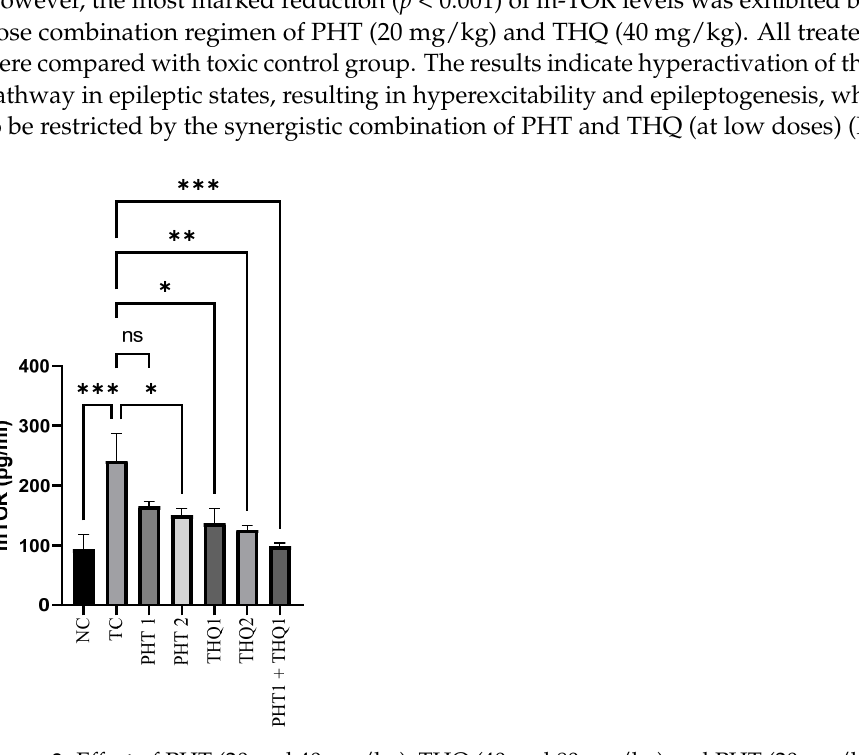
Figure 3. Effect of PHT (20 and 40 mg/kg), THQ (40 and 80 mg/kg) and PHT (20 mg/kg) + THQ (40 mg/kg) on hippocampal mTOR levels following MES-induced convulsions in rats. One-way ANOVA followed by Dunnet’s test was used to compare quantitative variables from the toxic con- trol vs. other groups. PHT, THQ, TC and MES indicate phenytoin, thymoquinone, toxic control and maximal electric shock, respectively. * p < 0.05, ** p < 0.01, *** p < 0.001 MES (180 mA, 220 V for 0.20 s) induced a substantial rise ( p < 0.001) in hippocampal IL-1 β levels in the toxic control group, compared to the normal control. PHT (20 and 40 mg/kg) reduced ( p < 0.05) IL-1 β levels. THQ (40 & 80 mg/kg) also reduced ( p < 0.01) IL-1 β levels. However, the most substantial reduction ( p < 0.001) was exhibited by the low dose combination regimen of PHT (20 mg/kg) and THQ (40 mg/kg). All treated groups were compared with the toxic control group. The results indicate electroshock-induced brain inflammation, resulting in hyperactivation and neuroinflammation, which were counter- acted well with the synergistic combination of PHT and THQ (at low doses) (Figure 4).